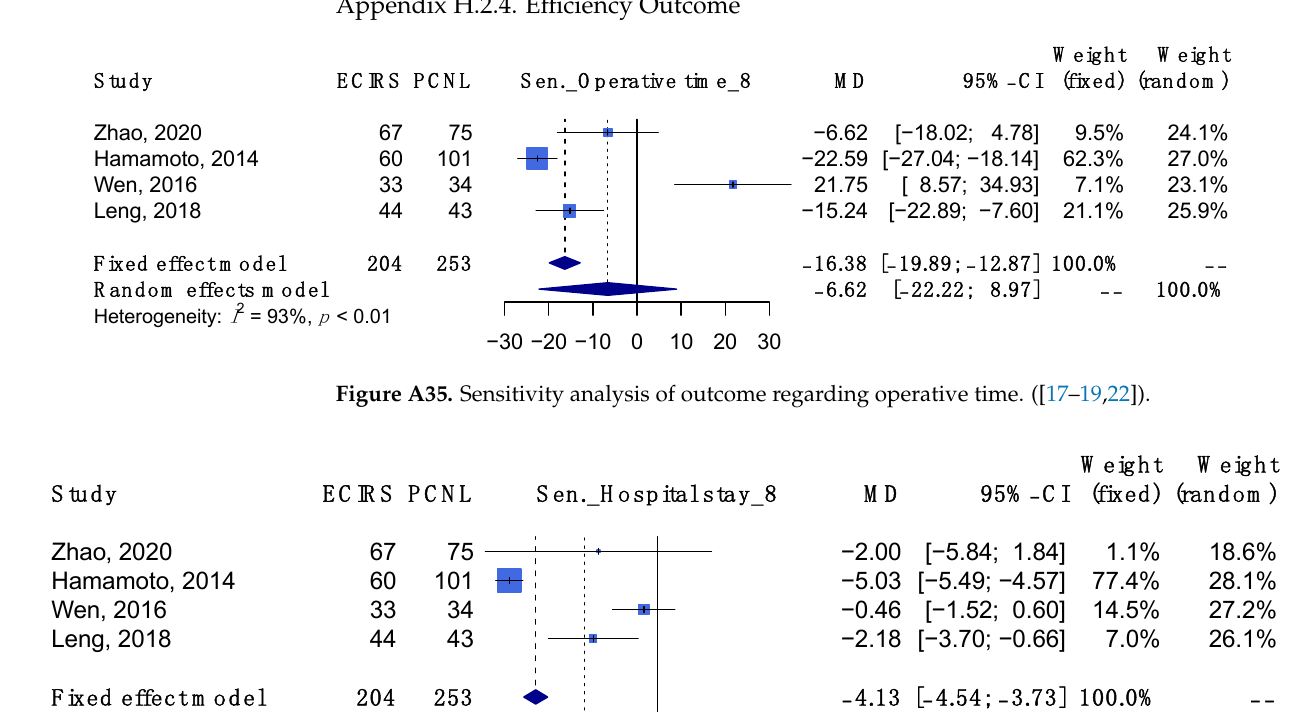
Figure A34. Sensitivity analysis of outcome regarding required blood transfusion. ([17–19,22])